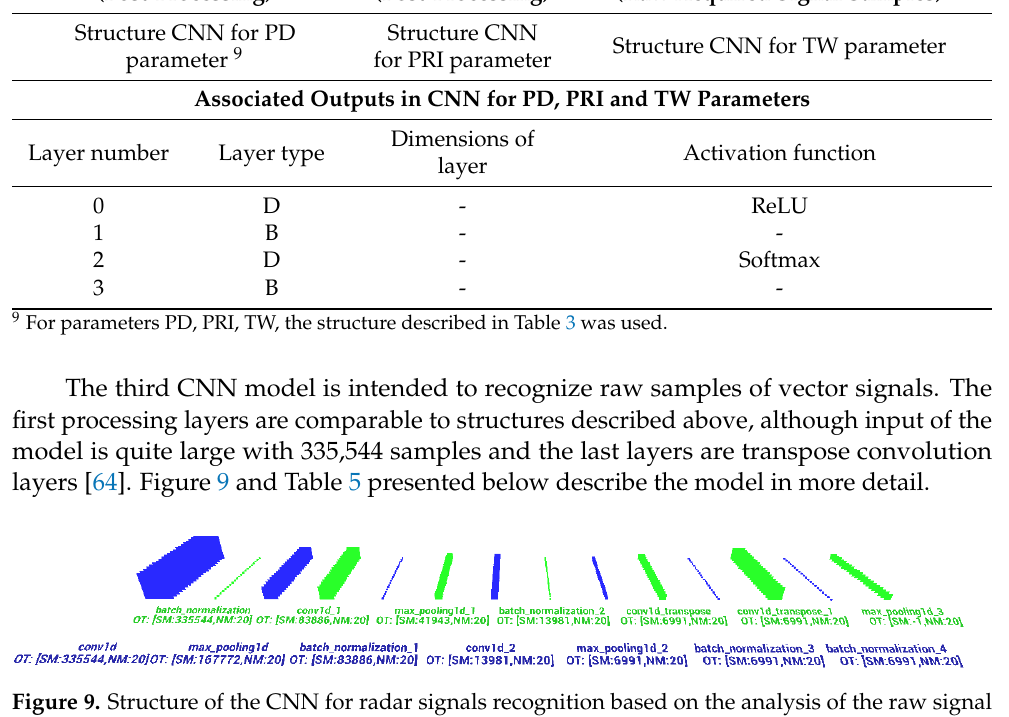
Figure 9. Structure of the CNN for radar signals recognition based on the analysis of the raw signal (raw samples of radar signal parameters). Table 5. Detailed structure of designed CNN for recognizing sampled signals.